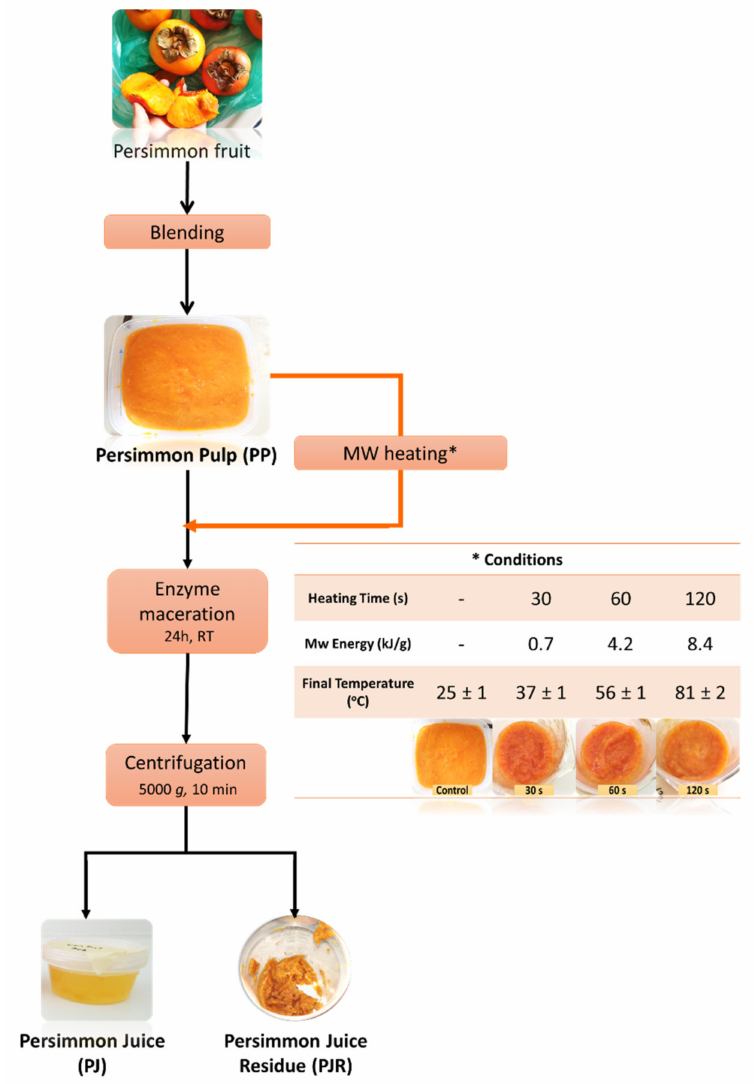
Figure 1. Flow diagram of persimmon juice processing without (black line) or after persimmon pulp treatment at different microwave (MW) heating conditions (red line) (the inset table shows the tested MW-heating conditions) (* the inset table shows the tested MW-heating